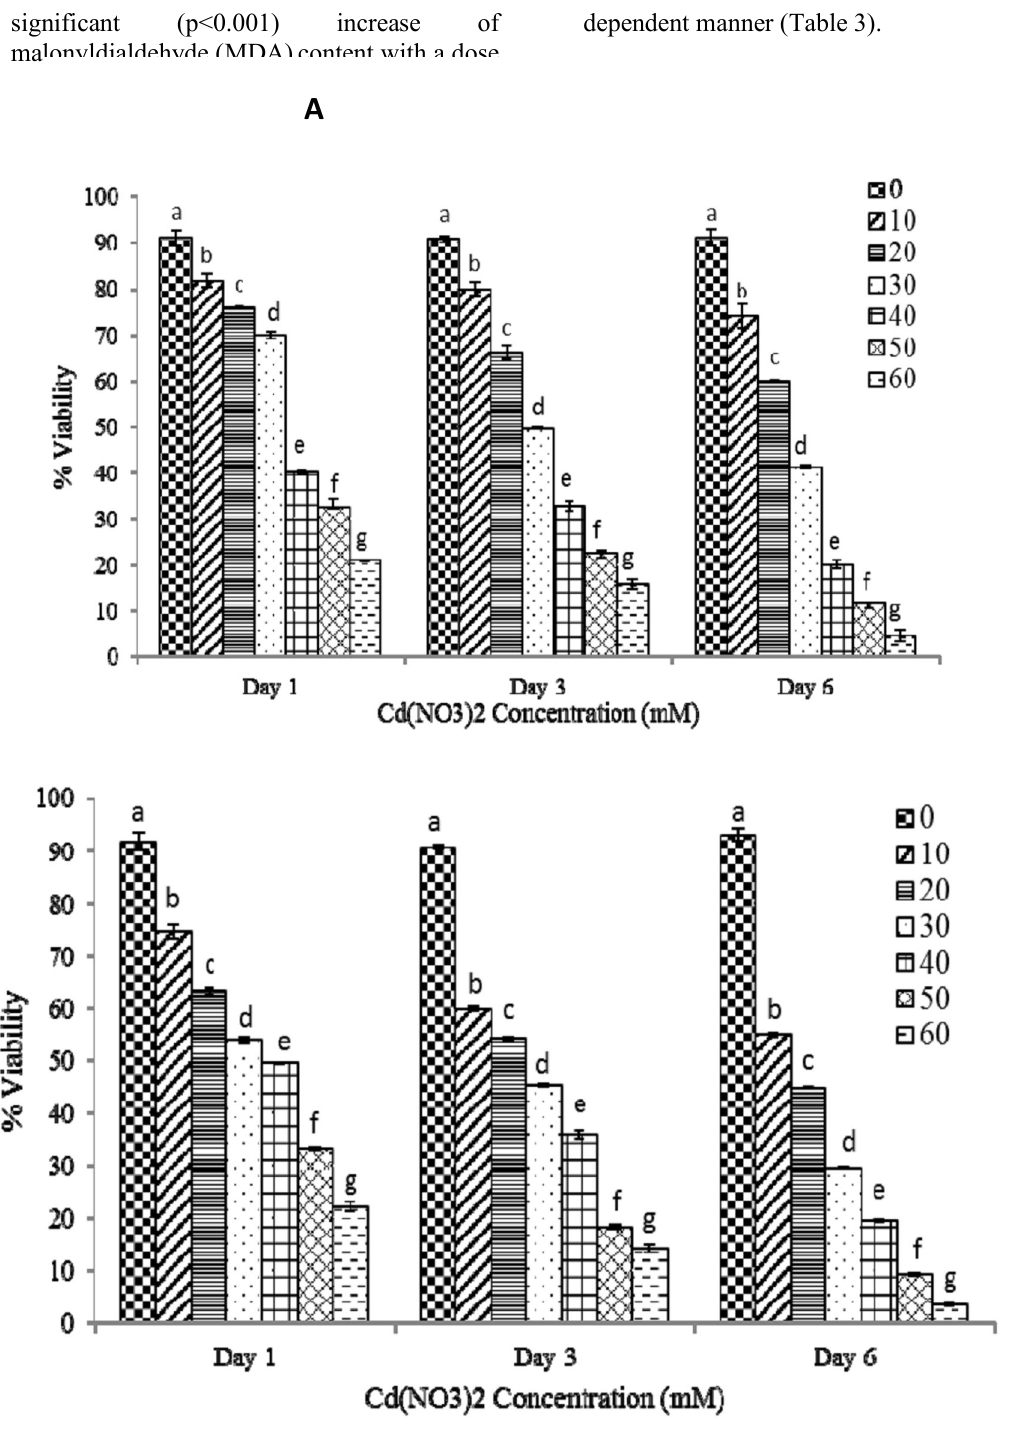
Fig. 1. Viability of the C. roseus callus cells after 1, 3 and 6 days of treatment with different concentrations of Cd(NO 3 ) 2 based on (A) Trypan blue staining and (B) MTT assay. Values are means ± SD. Means with different letter code differ significantly from each other in the same period of treatment (ANOVA, Duncan test,